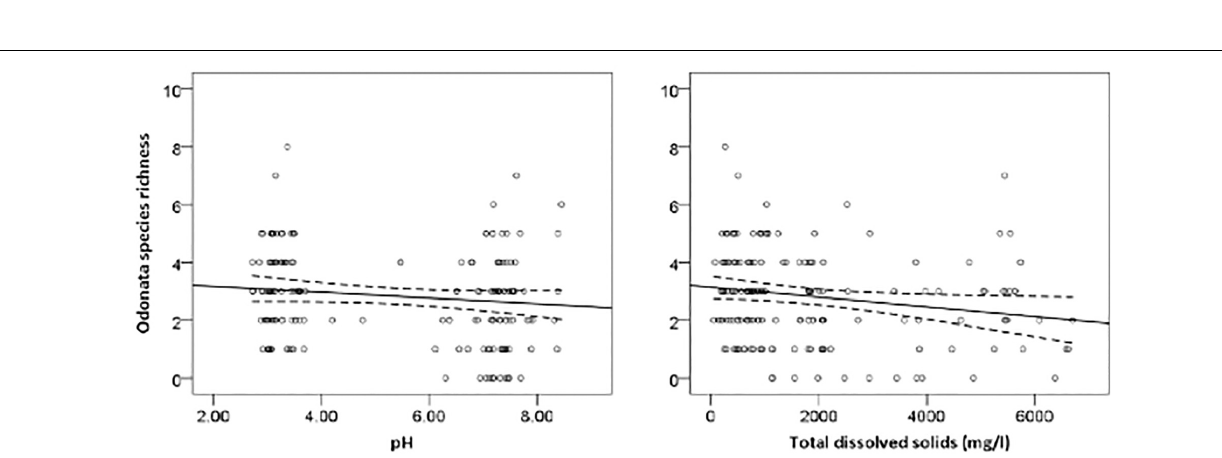
FIGURE 5 | Responses of Odonata species richness to water pH and total dissolved solids (mg/l). Based on GLMs, scatter plots have 95% confidence intervals (dashed) on the regression (solid) line.